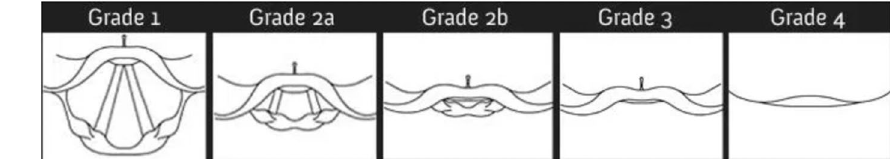
Fig. 4 Modified Cormack-Lehane Scoring System